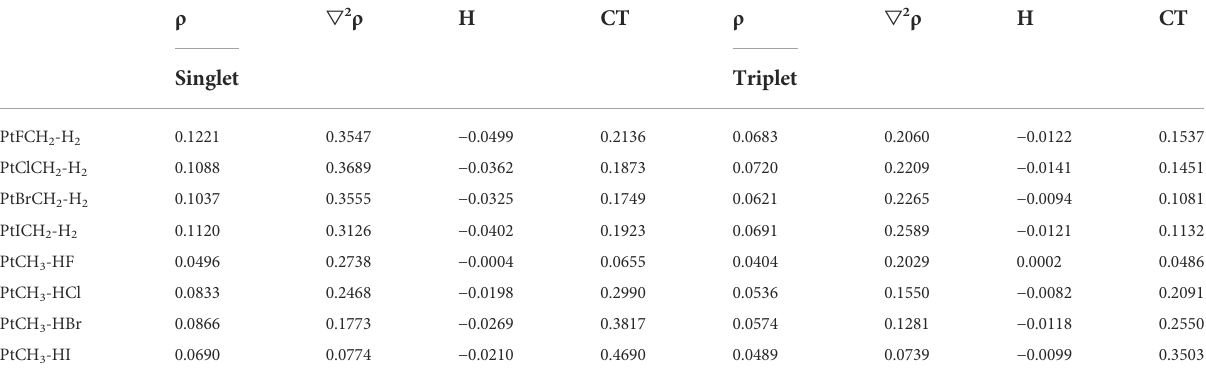
TABLE 5 Electron density ( ρ , a.u.), Laplacian ( ▽ 2 ρ , a.u.), energy density (H, a.u.), and charge transfer (CT, e) in the PtXCH 2 -H 2 and PtCH 3 -HX (X = F, Cl, Br, I) complexes. ρ ▽ 2 ρ H